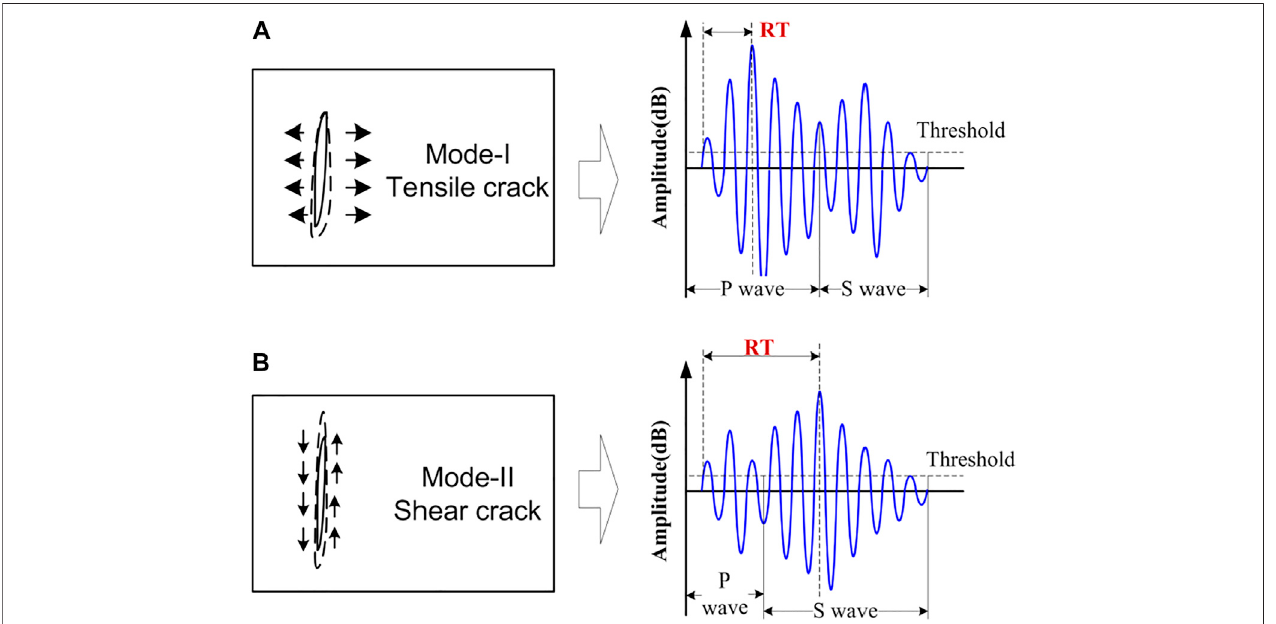
FIGURE11| RelationbetweencrackingmodesandcorrespondingAEwaveforms. (A) Model-I/TensilecrackcharacterisedwithlowerRTvalue,while (B) Model-II/ Shear crack characterised with longer RT value.